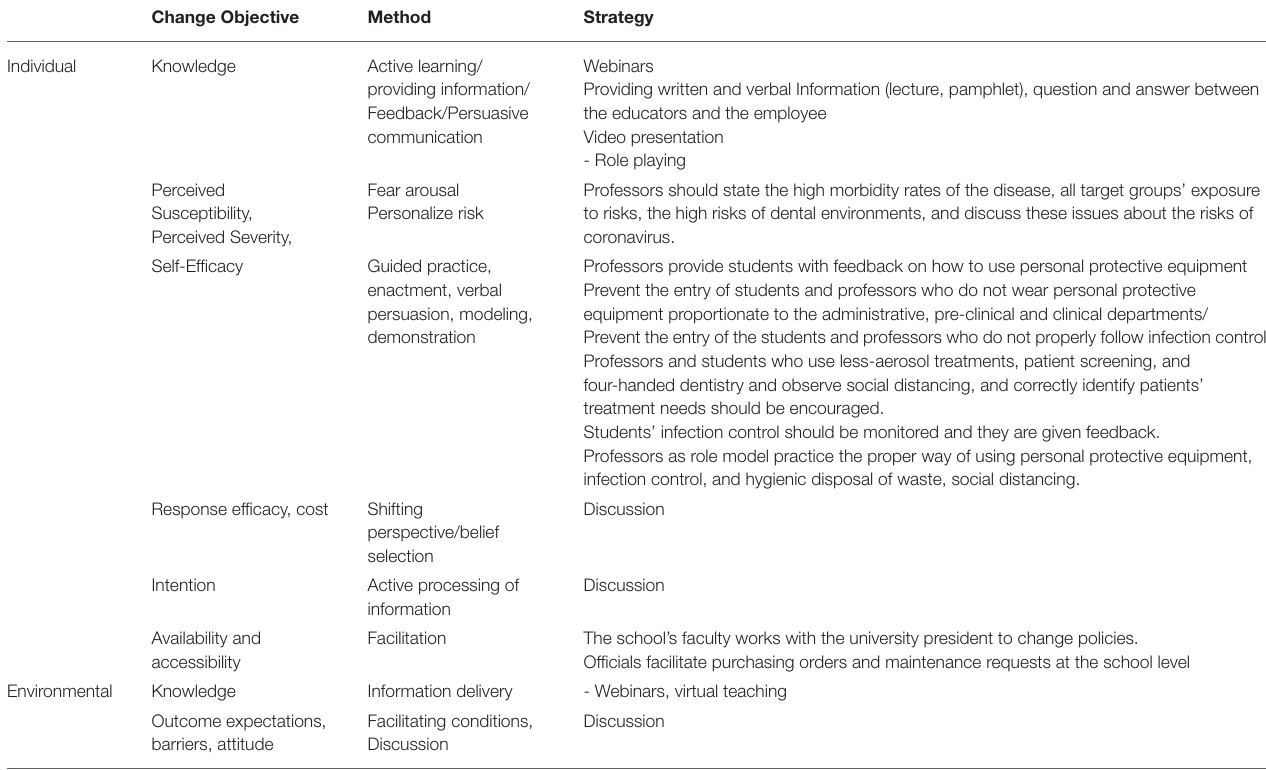
TABLE 4 | Overview of the selected theoretical methods and practical strategies used in the